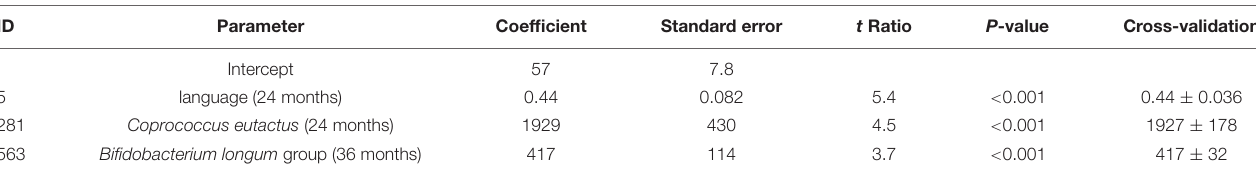
TABLE 1 | Prediction model for language